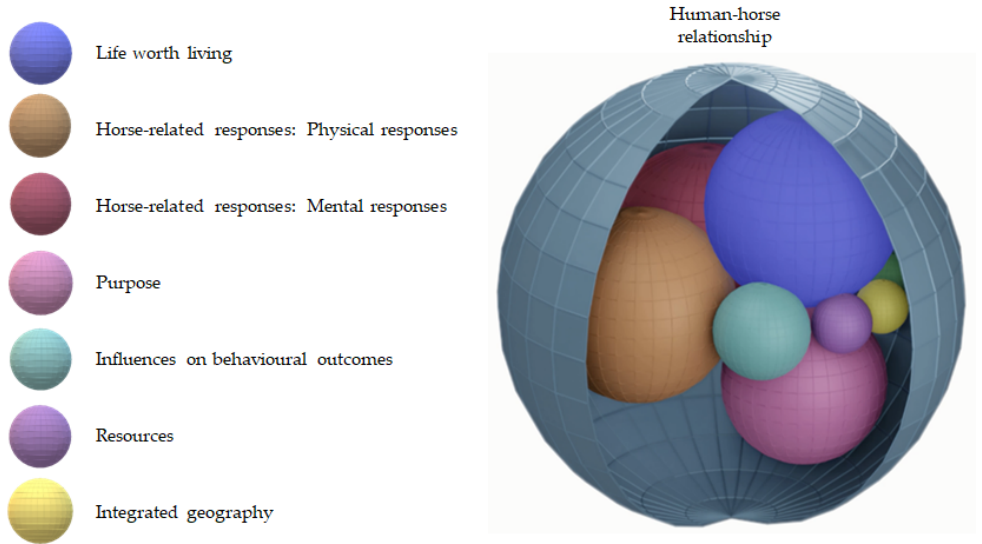
Figure 2. Image of the conceptual model representing the case example human–horse relationship and interaction of themes at a point in time.